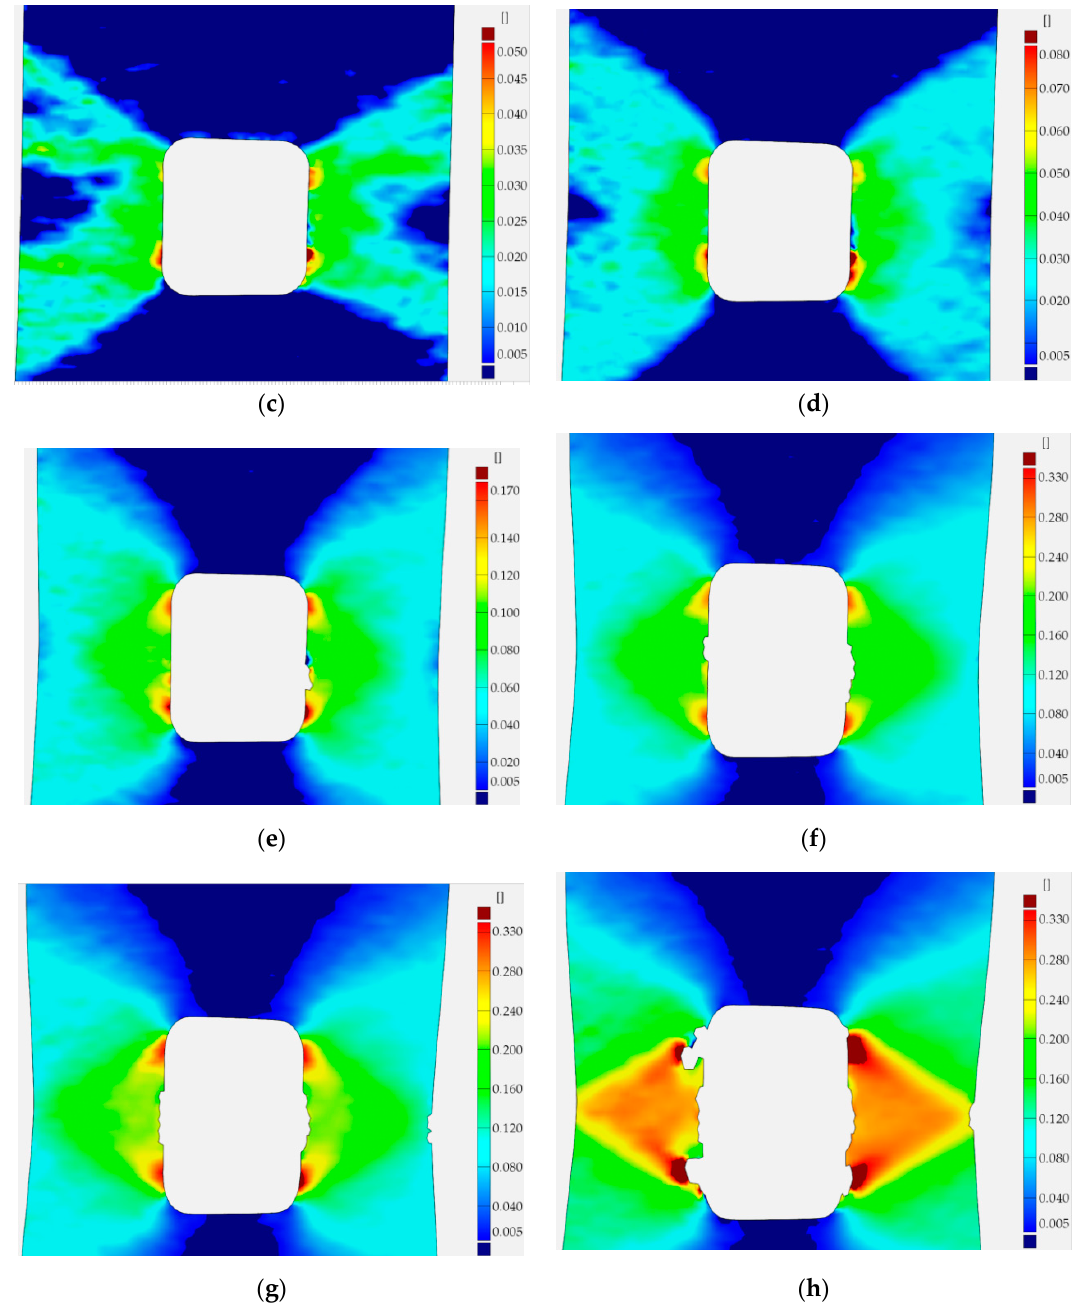
Figure 23. Distribution of the major vertical strains for S235JR + N plate with rectangular hole calculated with the use of DIC; total vertical displacement u MTS and corresponding vertical ε TOT (in brackets): ( a ) 0.74 (0.41); ( b ) 0.93 (0.51); ( c ) 1.57 (0.87) ( d ) 2.42 (1.35); ( e ) 5.59 (3.11); ( f ) 9.59 (5.33); ( g ) 10.26 (5.70); and ( h ) 13.25 (7.37).